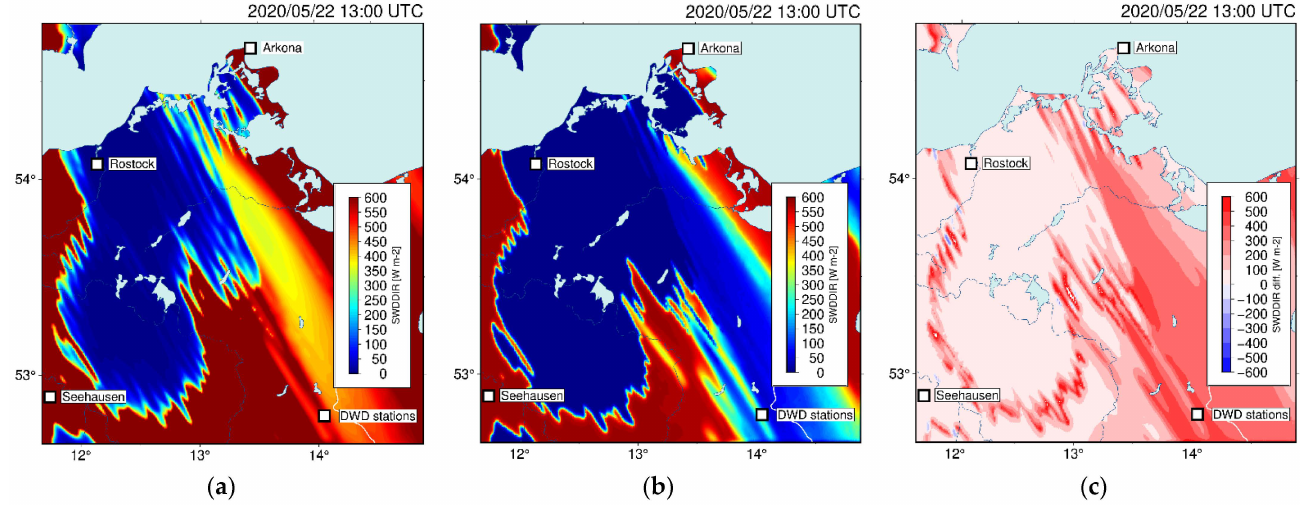
Figure 9. Shortwave surface downward direct irradiance ( SWDDIR ) forecast for 22 May 2020